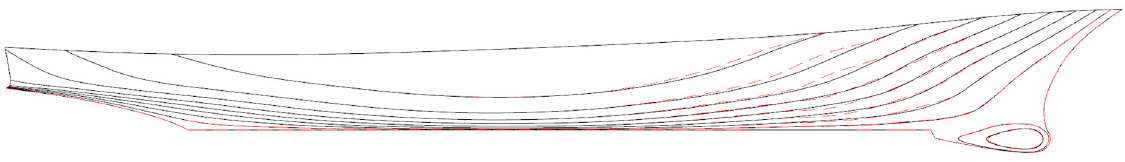
Figure 17. Comparison of profile views of optimized and original hull forms.